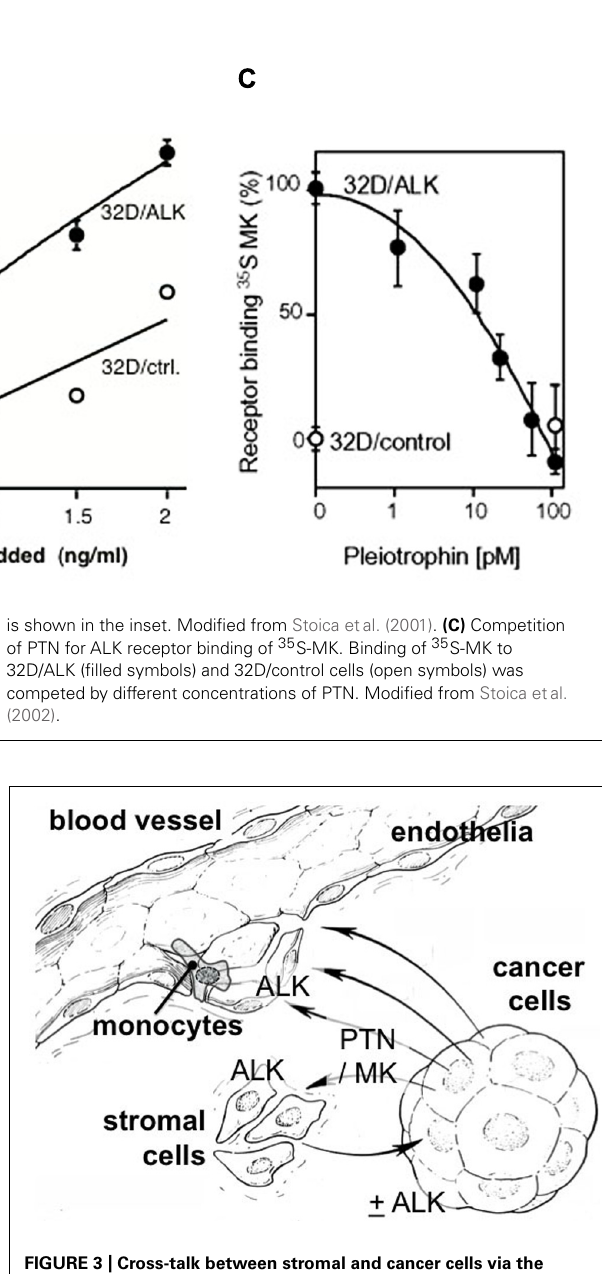
FIGURE 3 | Cross-talk between stromal and cancer cells via the PTN/MK–ALK pathway. PTN and MK are heparin-binding proteins released from cancer or stromal cells.They can bind at nanomolar affinity to glycosaminoglycans (GAGs) such as the heparan sulfate side chains of proteoglycan (HSPG) as well as chondroitin sulfate (CS; Deepa etal., 2002). CS is proposed as a co-receptor for MK (Muramatsu, 2010) as are other GAGs (Li etal., 2010). Also N -syndecan could function as such a co-receptor (Raulo etal., 1994). Both ligands and receptor can be found up-regulated in the stroma of cancer as well as in cancer epithelia (see